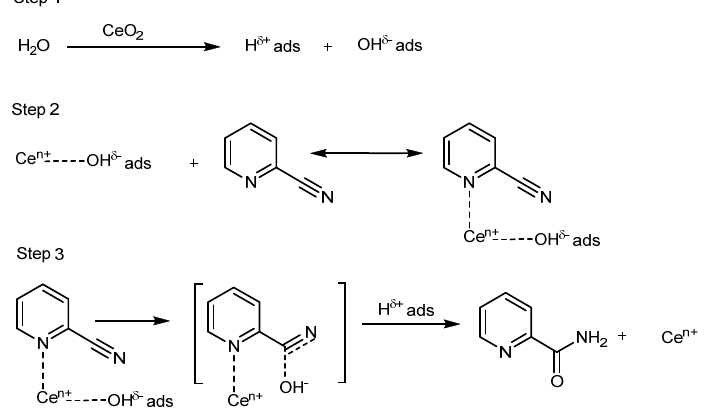
Figure 5. Reaction mechanism for the 2-cyanopyridine hydrolysis, as proposed by Tamura et al. [57]. (Reprinted/adapted with permission from Ref. [57], 2011, John Wiley and Sons)